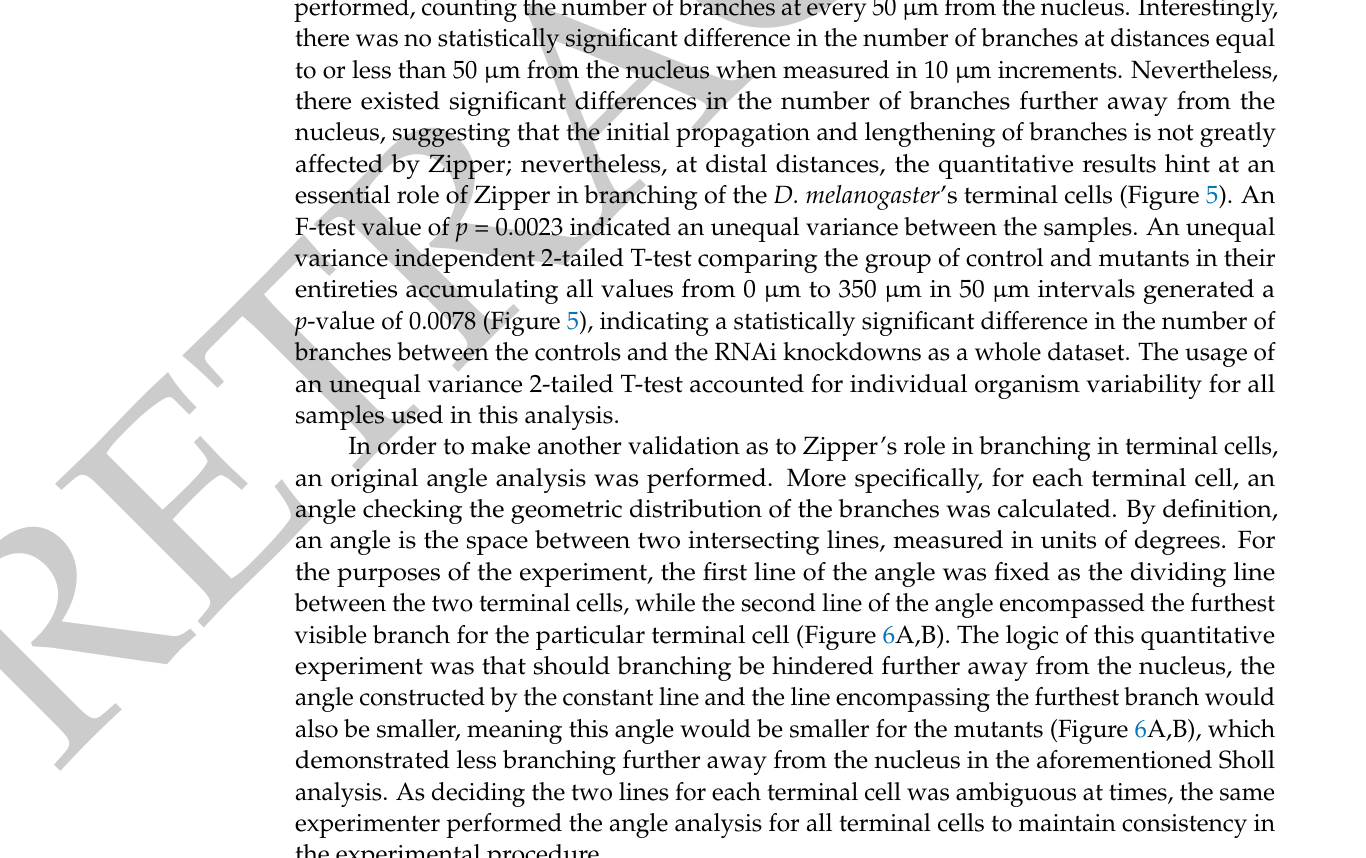
Figure 4. Branching morphogenesis of Zipper-rescued mutants from Figure 3. ( A ) and ( B ) represent the Zipper-rescued experimental terminal cells of heat-killed larvae using an alternative stock of fruit flies.